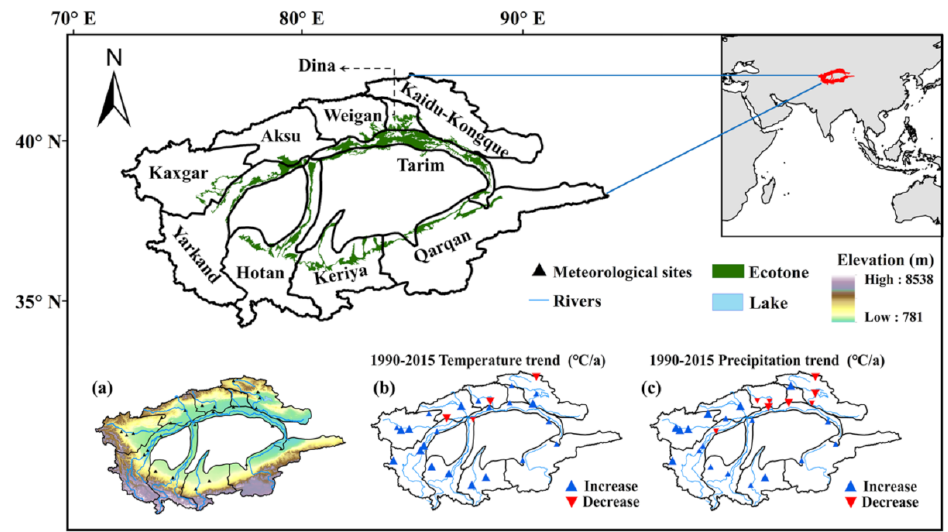
Figure 1. Map of the study area showing the Tarim River Basin and its nine main tributary river basins: the Kaidu-Kongque, Aksu, Weigan, Yarkand, Qarqan, Dina, Hotan, Kaxgar, and Keriya river basins; ( a ) the elevation of this area ranges from 781 to 8538 m above sea level; the spatial and temporal distribution of ( b ) temperature and ( c ) precipitation changes from 1990 to 2015. The black triangles represent the meteorological stations. Blue and red represent the increase and decrease, respectively, and the size of the triangle represents the magnitude of the